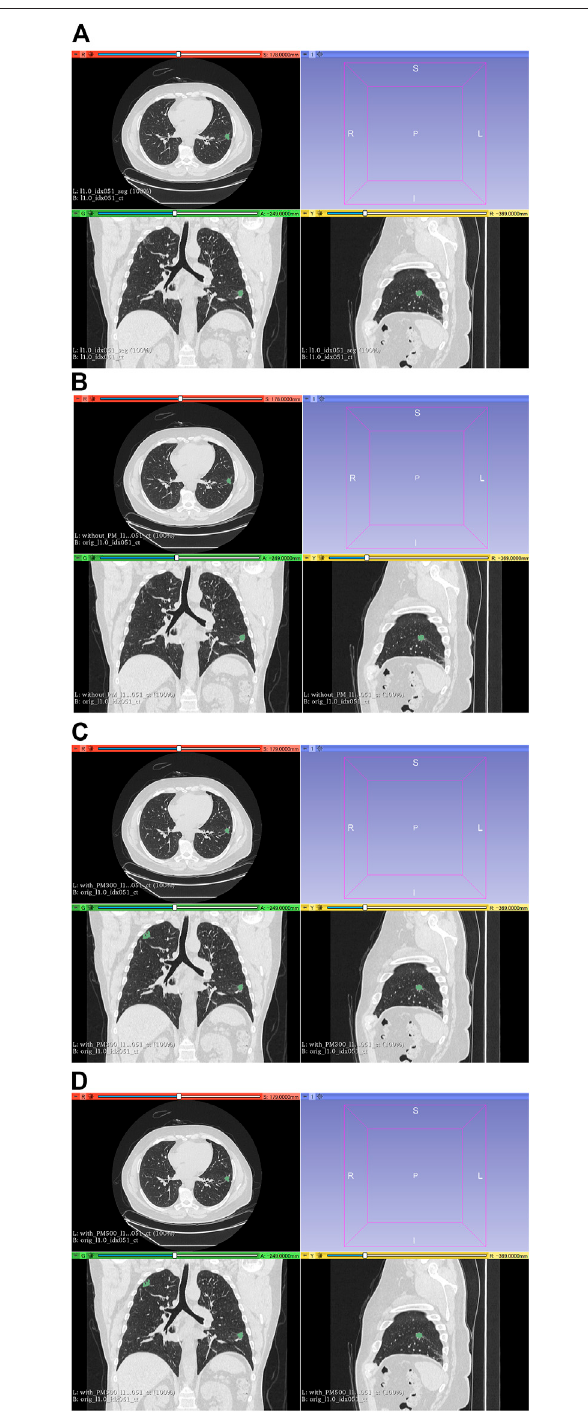
FIGURE 7 | Results of segmentation in case 3 of test set. (A) CT images and ground-truthlabels. (B) CTimagesand segmentation resultswithoutPM. (C) CT images and segmentation results with PM 300 . (D) CT images and segmentation results with PM 500 . Note: Because of PM, a part of the right upper fi eld is incorrectly segmented as lung cancer in (C) and (D) . Abbreviation: PM, pretrained model; PM 300 , pretrained model obtained from 300epochsoftraining;PM 500 ,pretrainedmodelobtainedfrom500epochsof training.